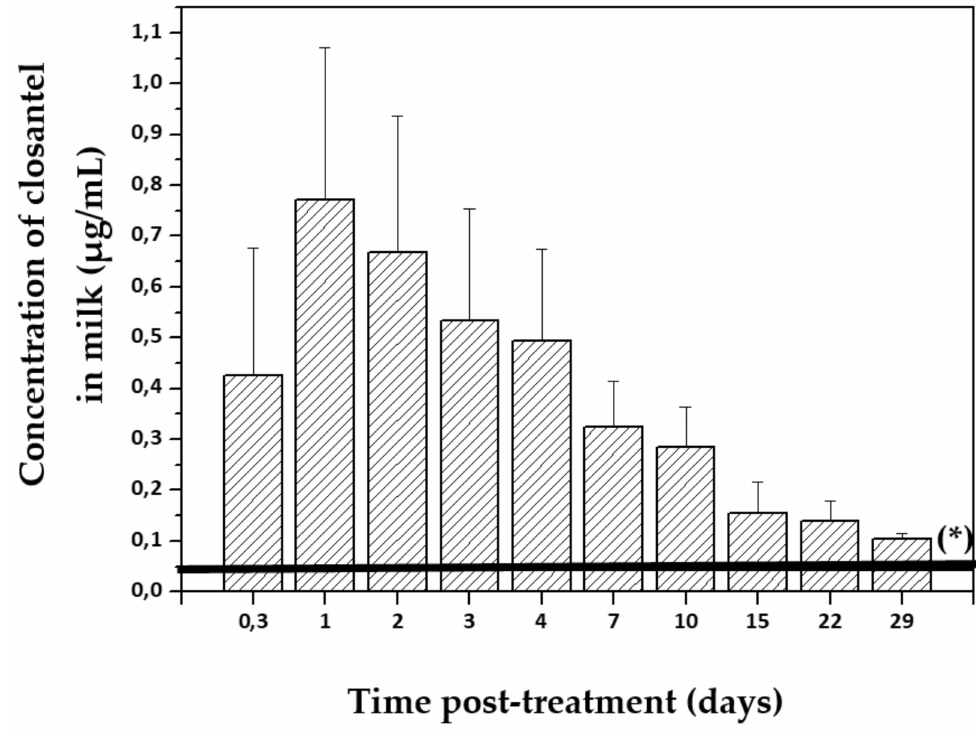
Figure 3. Closantel residue levels (mean ± SD) measured in the milk collected from dairy goats ( n = 6) at different times after oral treatment (10 mg/kg). (*) MRL: the maximum residue limit according to the European Medicines Agency is 45 µ g/kg [102]. Source: Adapted from Iezzi et al.